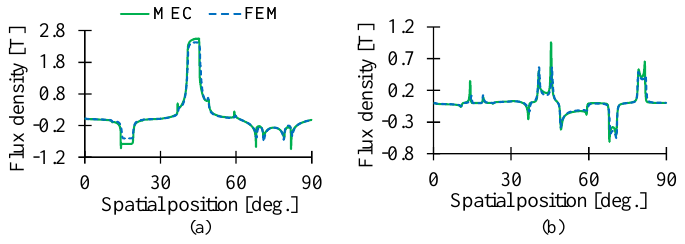
Figure 25. Airgap flux density at θ elec , phA = 240 ◦ for phase currents in Figure 21: (a) radial component and (b) tangential component.